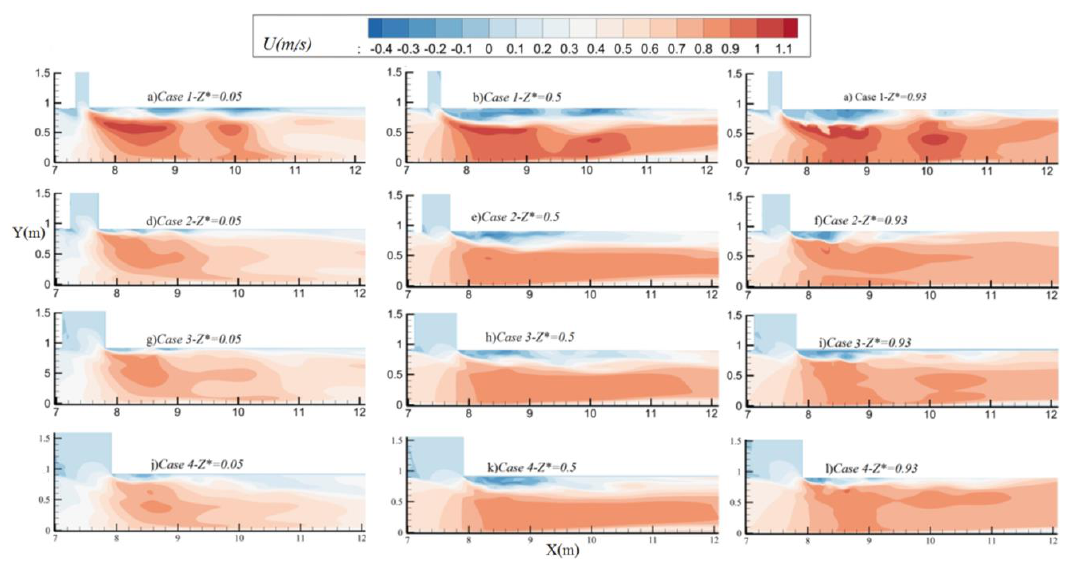
Figure 4. The distribution of the stream-wise component of velocity (U) in the rectangular channel.